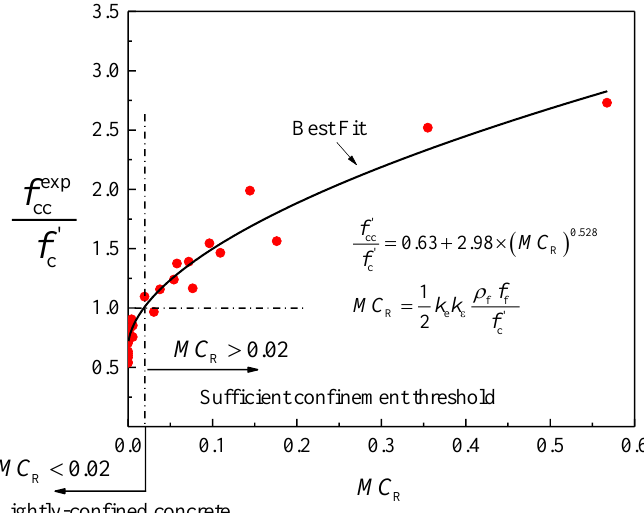
Figure 4. Relationship between effective confinement pressure ratio and ratio of the confined peak strength to the unconfined concrete strength.